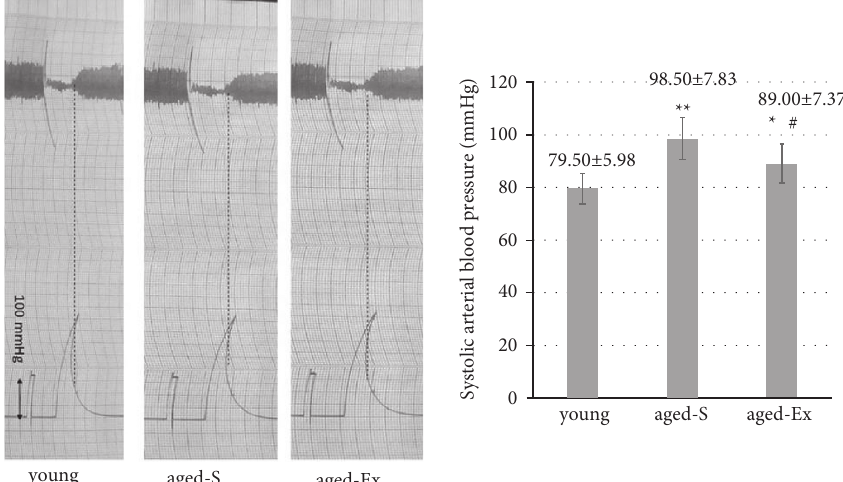
Figure 1: Representative traces and statistical analysis of systolic blood pressure measurements in young, sedentary aged (aged-S), and exercised aged (aged-Ex) rats. ∗ indicates P < 0 . 05; ∗∗ indicates P < 0 . 001 compared with the young group; # indicates P < 0 . 05; ## indicates P < 0 . 001 compared with the aged-S group. The data are expressed as mean ± SD ( n �